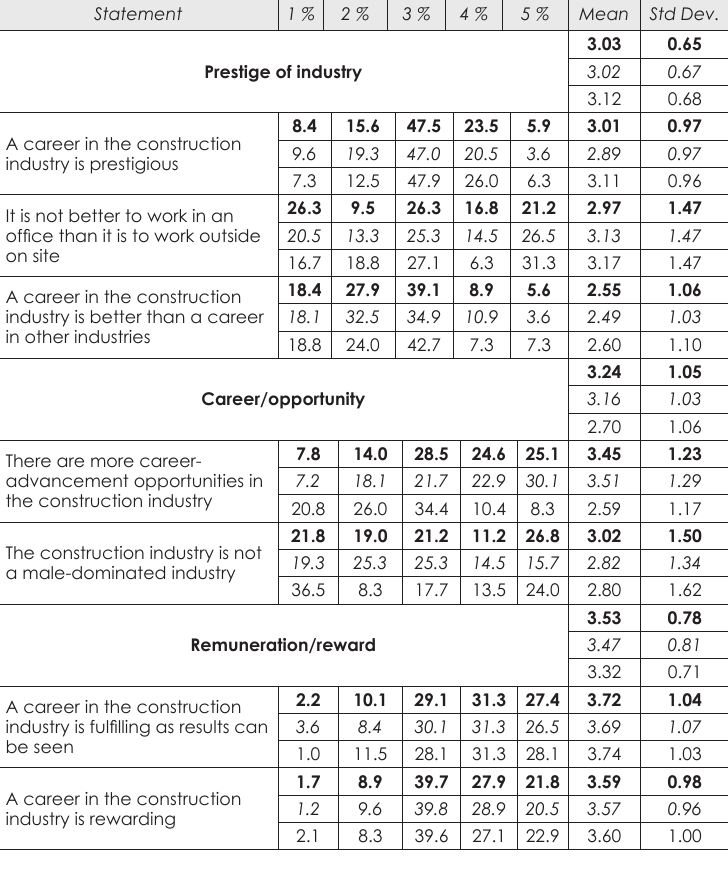
Table 4: Perceptions of industry (n=179; n